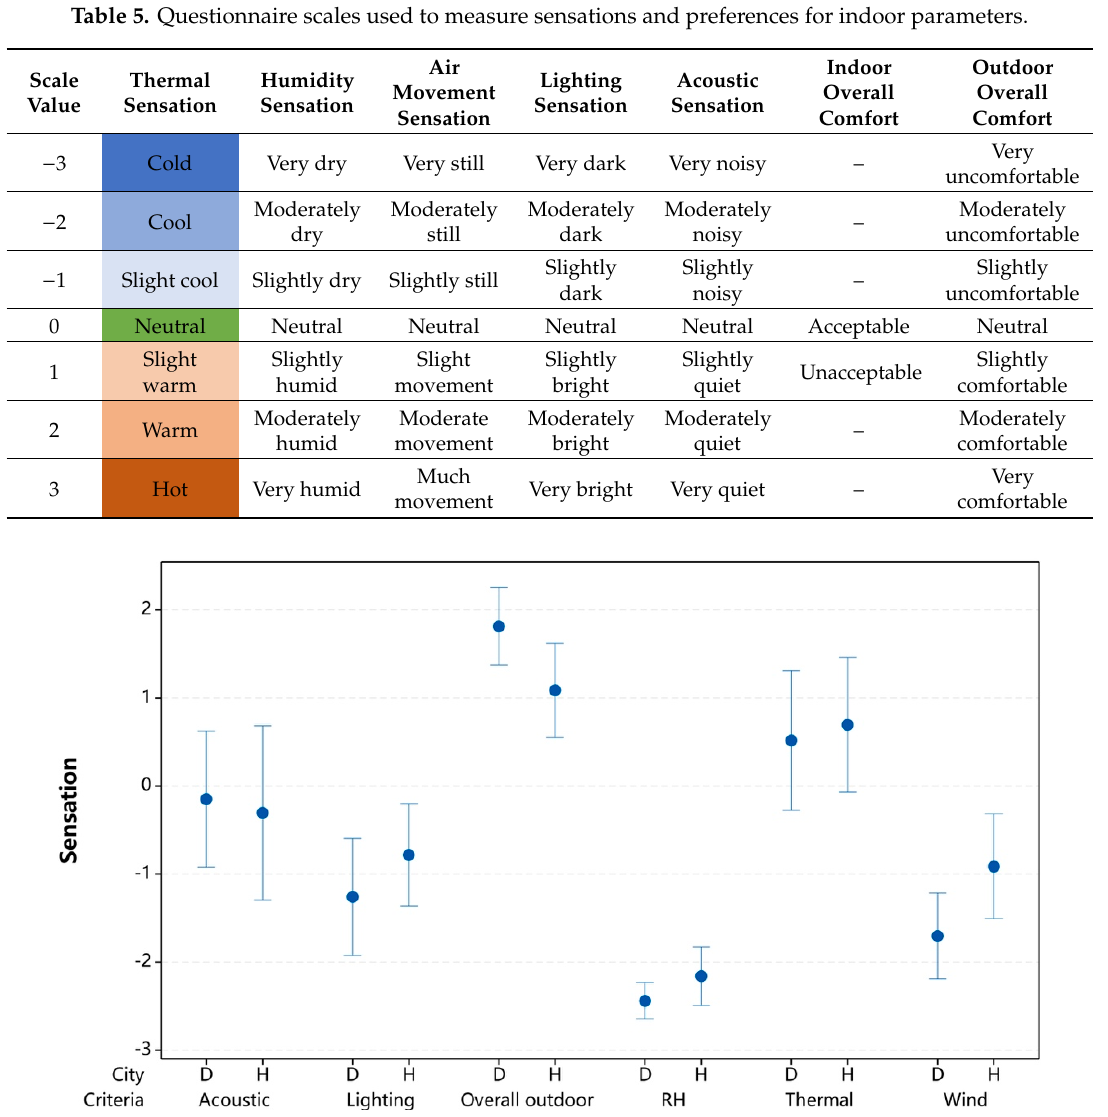
Figure 15. Interval plot of indoor sensations from questionnaire responses.